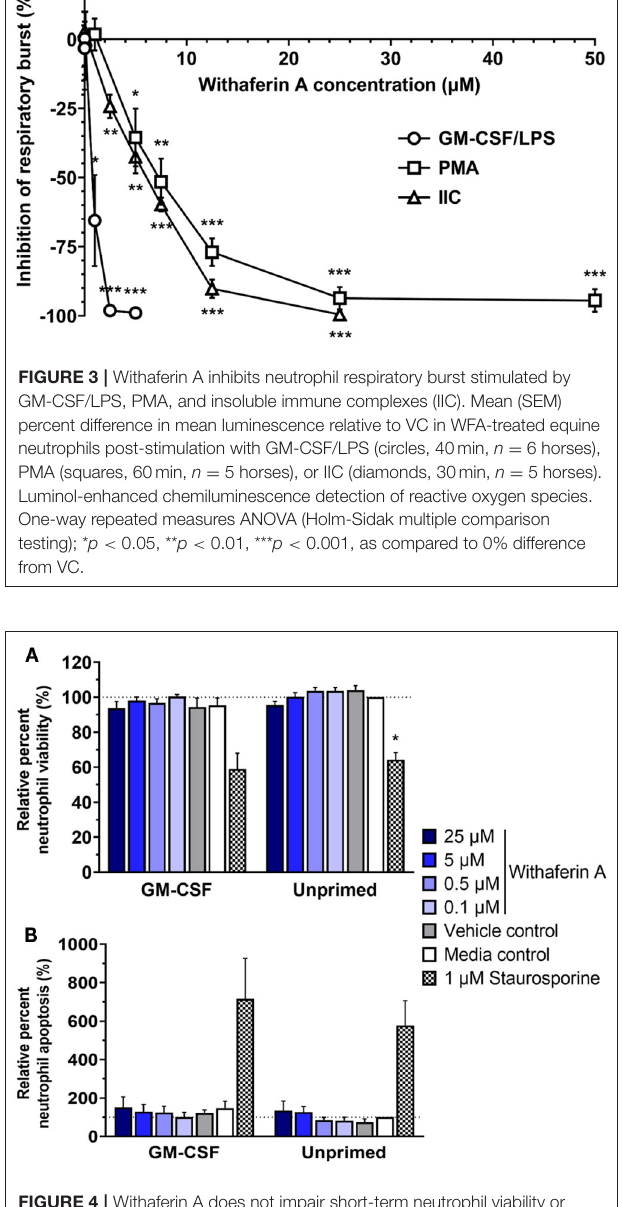
V − /propidium iodide − ) and to quantify apoptotic